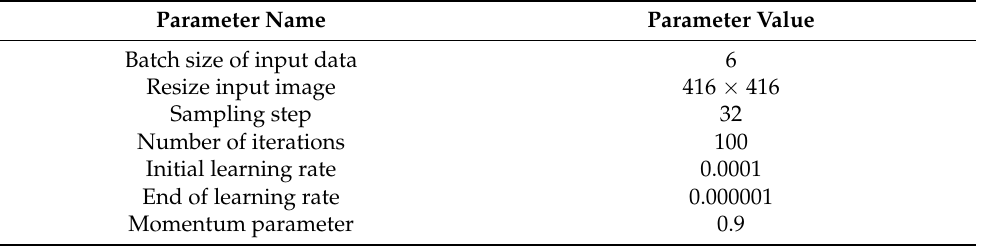
Table 1. Network training parameters.